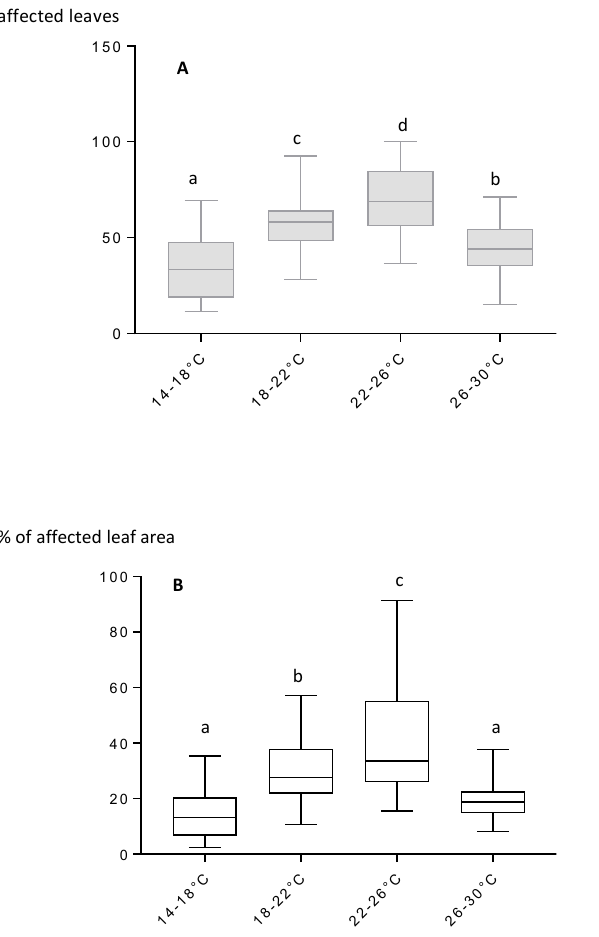
Figure 1. Effects of different temperature regimes (14–18, 18–22, 22–26 and 26–30°C) on the disease caused by Al- lophoma tropica on lettuce (cv. Elisa). A) Mean disease in- cidence, % of affected leaves. B) disease severity, % of leaf are affected. Mean value of trials 1–6. Data accompanied by the same letter are not significantly different, accord- ing to Tukey’s Test ( P <0.05). The boxes represent the inter- quartile range (IQR) between the first and third quartiles, and the lines inside the boxes represent the median (2 nd quartile). The whiskers denote the least and the greatest values within 1.56 IQR from, respectively, the first and third quartiles.